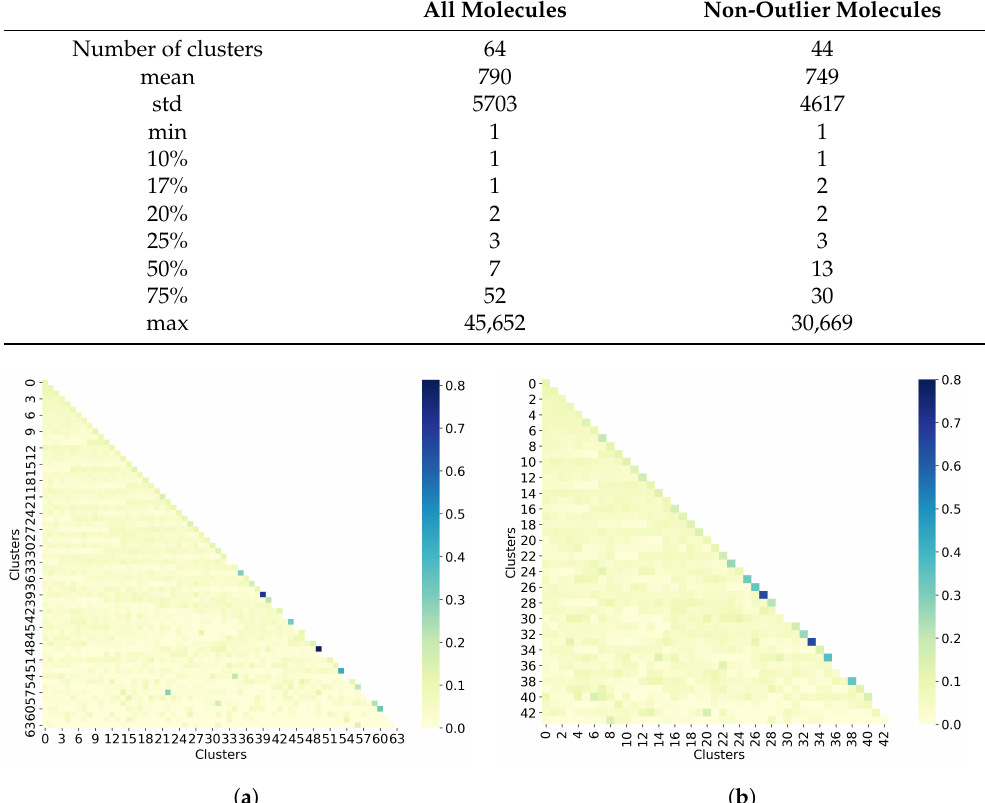
Figure 6. Taylor-Butina clustering with similarity cutoff = 0.90. ( a ) Clustering of all 50,555 molecules results in 64 clusters, and ( b ) clustering of 32,971 non-outlier molecules results in 44 clusters. Outlier molecules were removed using an outlier cutoff of 0.5 (see Section 3.1 for more details about outlier detection). The matrix is calculated as the average Tanimoto similarity between the molecules of cluster i and those in cluster j , and the average similarity between molecules of a cluster and itself (see Section 2.3 for more details on how this matrix is calculated). The matrices have been adjusted to the same scale to facilitate clustering comparison between all molecules and non-outlier molecules. The average similarity between one cluster and itself (diagonal) is substantially higher than the average similarity between two different clusters (off-diagonal). However, these values may be biased by the number of molecules per